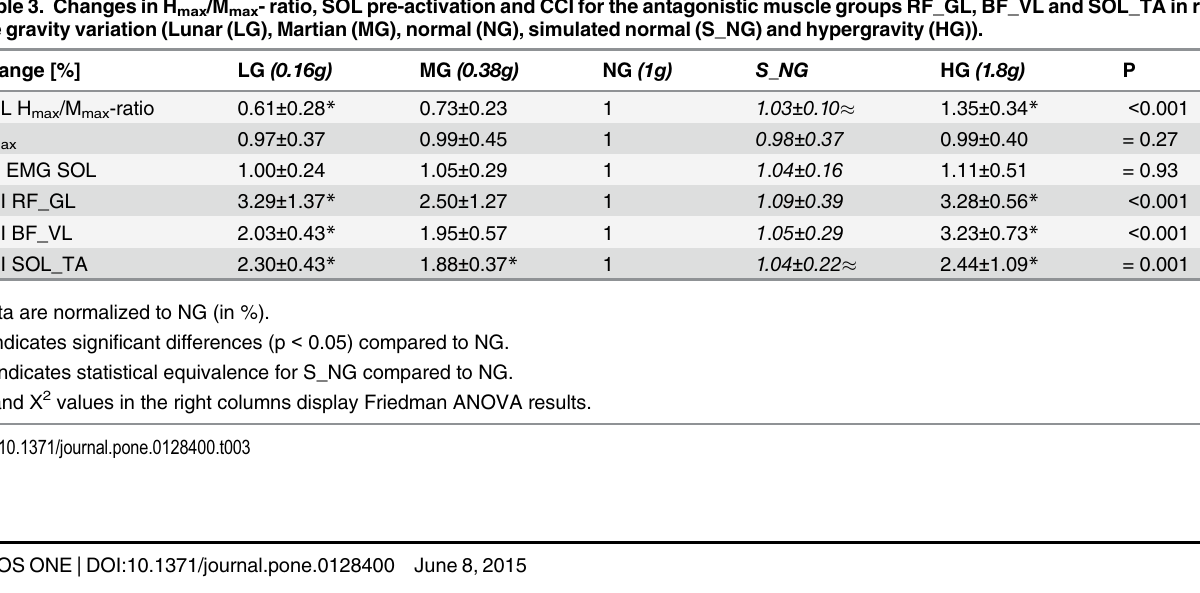
Fig 5. Grand mean of the parameters associated with neuromuscular changes in under and over loading collected in four gravity levels (lunar (LG, grey background), Martian (MG, grey), normal gravity (NG, white) and hypergravity (HG, grey)) as well as during simulated normal gravity (S_NG, white): Co-contraction index (CCI) for the antagonistic muscle groups SOL_TA, BF_VL and RF_GL, H max /M max -ratios and the iEMG 100ms prior to the H-reflex stimulation for SOL. Data are normalized to the respective NG value. For NG, both the absolute values and the relative values are displayed. Load variation has a statistically significant influence on all parameters (P < 0.05, * symbol denotes a statistically significant difference compared to the 1g condition) despite the pre-activation of SOL. Statistical equivalence (cid:3) between NG and S_NG conditions values could be observed for all parameters despite for CCI BF_VL.